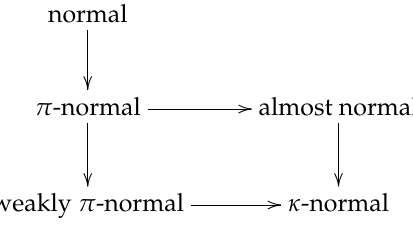
Figure 2. Interrelation of variants of